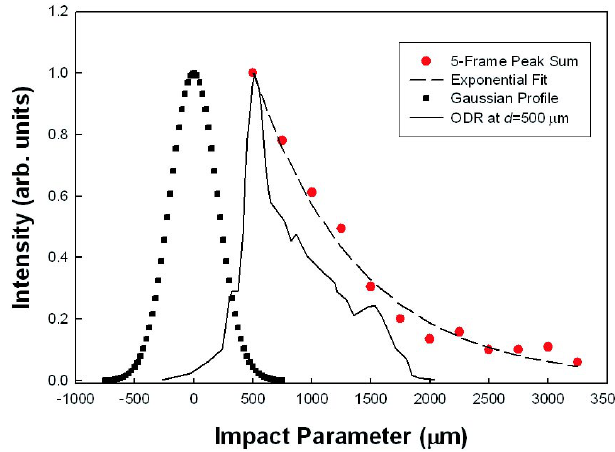
FIG. 6. (Color) Plots of the ODR peak intensity versus the distance from the beam to blade edge or impact parameter, an exponential curve fit to the data with (cid:1)(cid:3) = 2 equal to 909 (cid:2) m , and an initial ODR y profile are shown. A Gaussian fit to the OTR (cid:5) 200 (cid:2) m centered at d (cid:5) 0 is also beam distribution for (cid:5) y shown for reference.